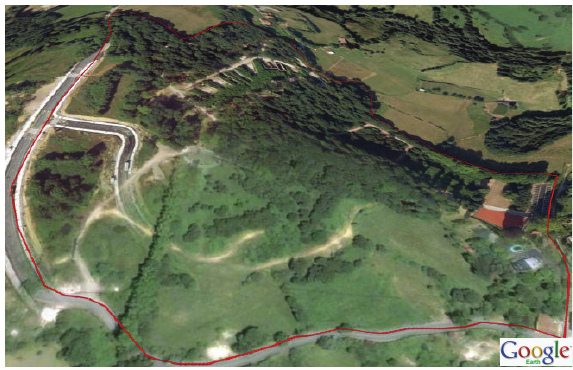
Figure 1: View of the study area (source: Google